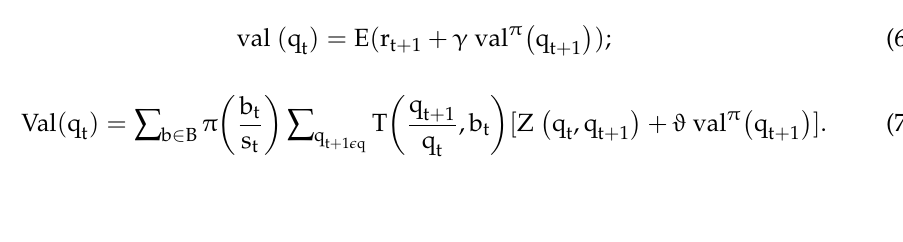
Figure 4. Framework of the DQN Model .